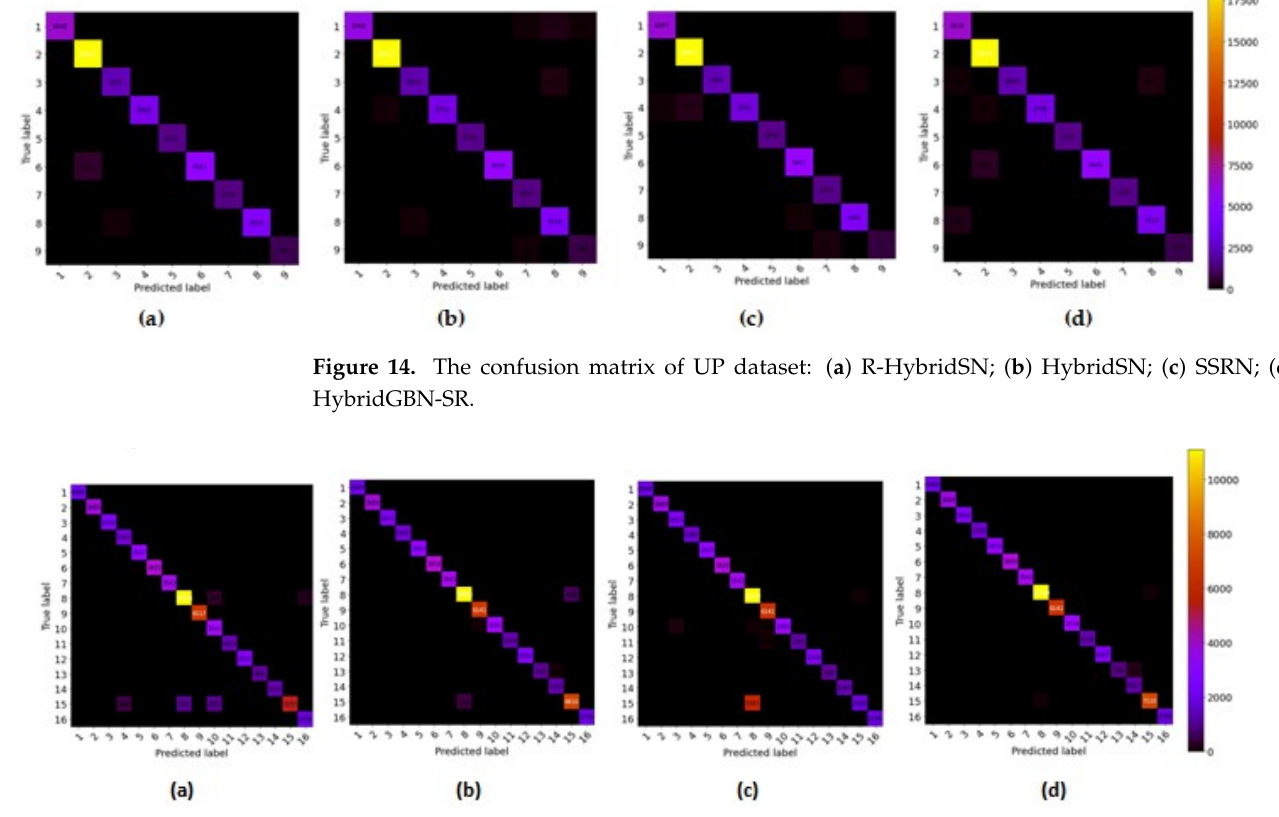
Figure 15. The confusion matrix of SA dataset: ( a ) R-HybridSN; ( b ) HybridSN; ( c ) SSRN; ( d ) HybridGBN-SR.